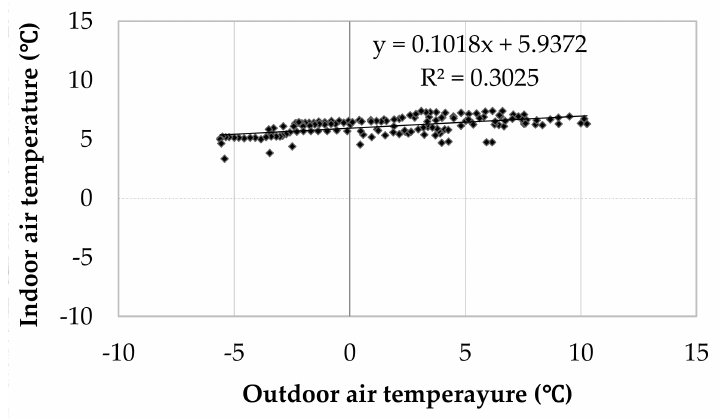
Figure 6. Relationship between indoor and outdoor temperatures in